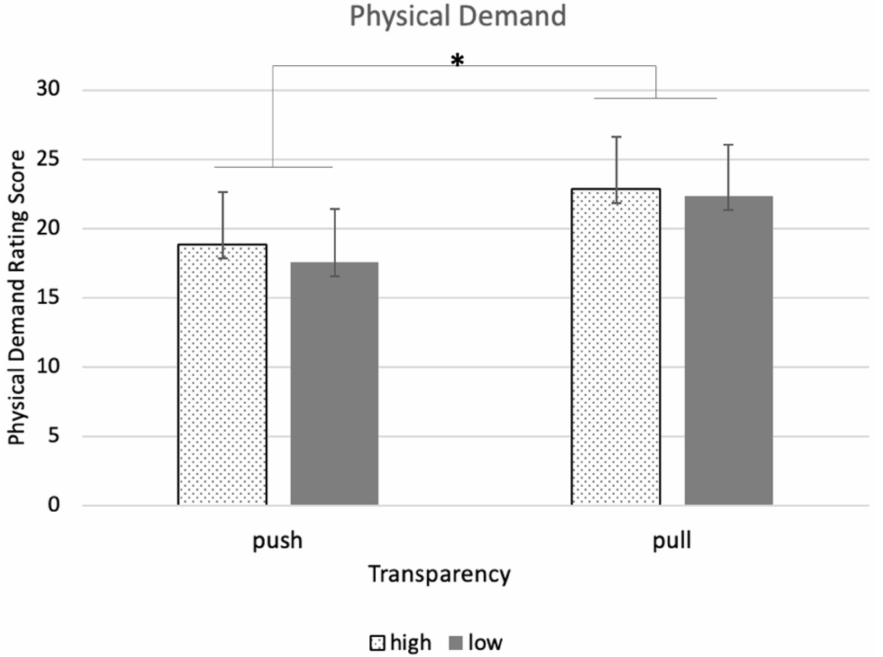
Figure 5. Physical demand measured by NASA/TLX in all conditions (* p < 0.05) [error bars indicate standard errors]. Table 7. NASA/TLX